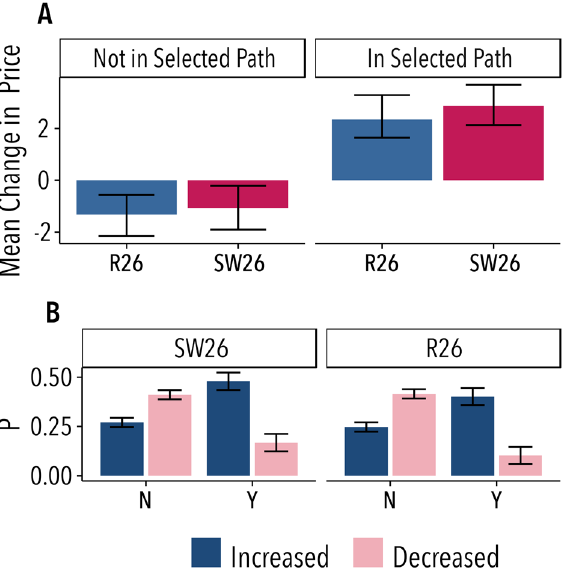
Figure 3. Being or not in the cheapest path determines the intermediaries price increases. ( A ) Mean changes in the posted price conditioned to have been (right) or not (left) in the selected cheapest path in the previous round for the random networks of 26 nodes (R26), and for the small-world network of 26 nodes (SW26). ( B ) Probability to increase (blue) and to decrease (pink) the posted price conditioned to have been (Y) or not (N) in the selected cheapest path, for each one of the studied networks. The error bars represent the 95% C.I. An extension of these results including the 50-nodes Random Network is displayed in SI Fig. S3. Figure created using ggplot2 (v.3.2.1) 21 .